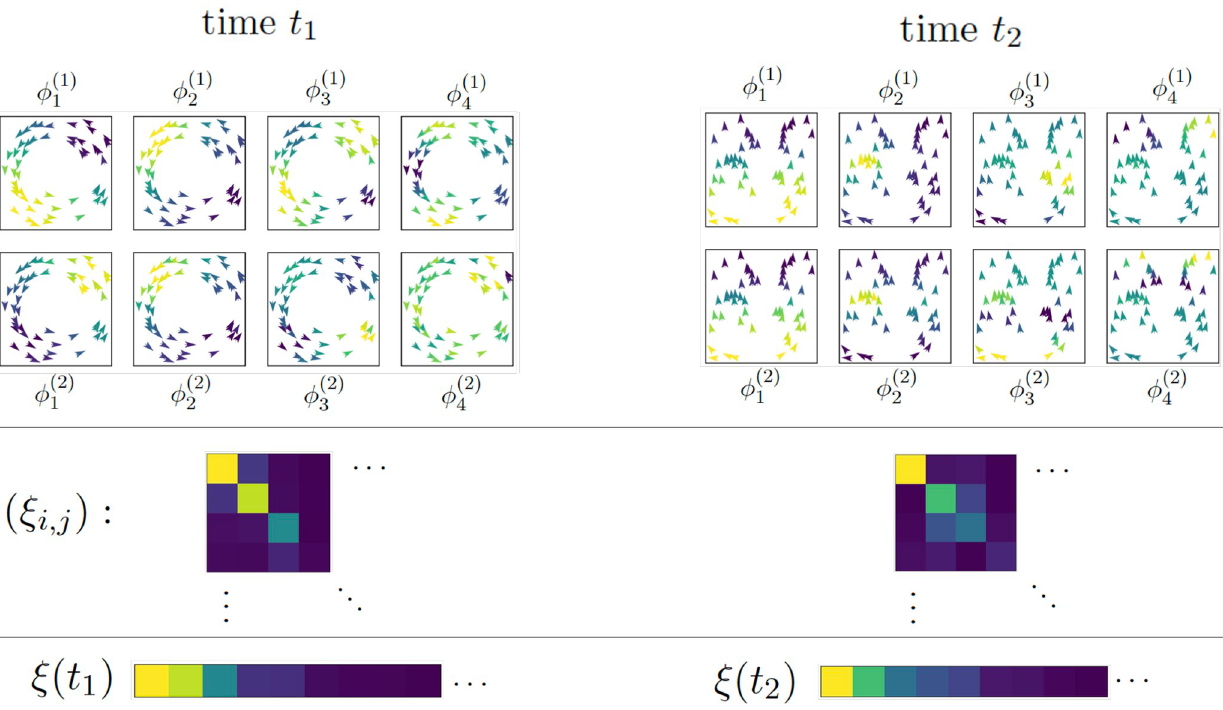
PLOS Computational Biology | https://doi.org/10.1371/journal.pcbi.1007811 February12,